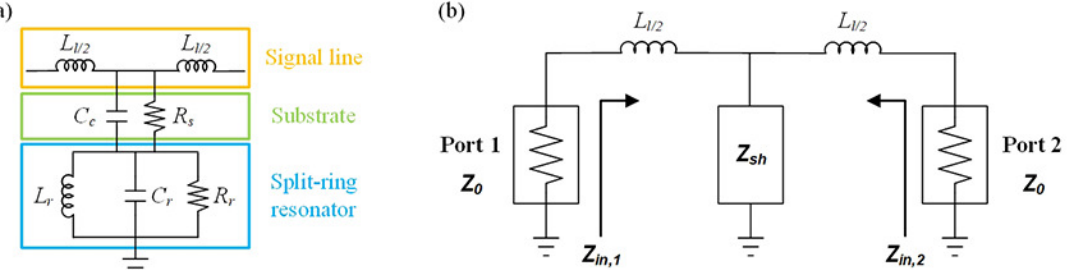
Figure 4. The equivalent circuit model of the proposed sensor. ( a ) complementary split-ring resonator; ( b ) simplified circuit model with port termination for transmission